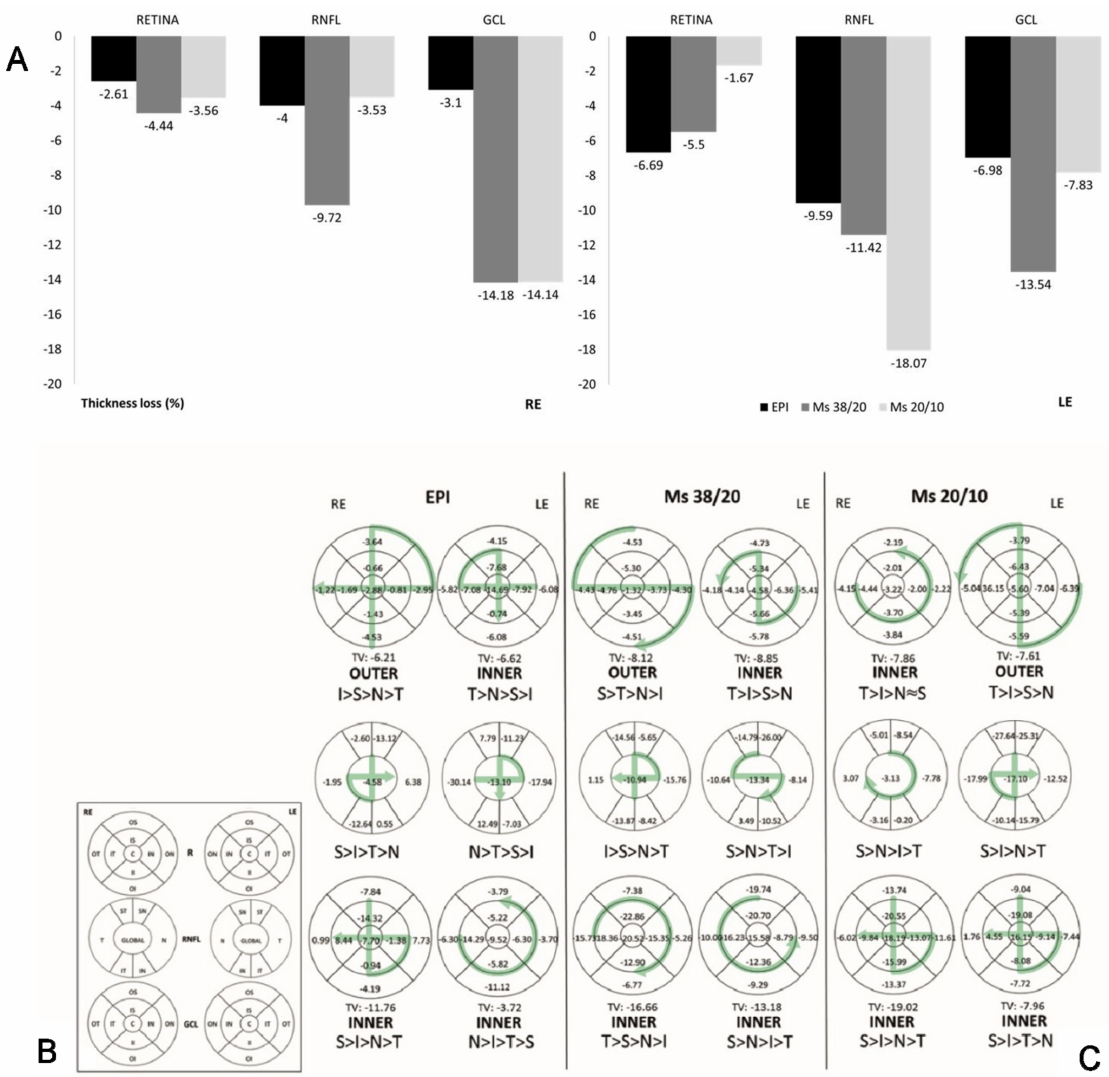
Figure 5. Percentage loss of neuroretinal structure identified by optical coherence tomography (OCT). ( A ) Percentage loss of retina, retinal nerve fiber and ganglion cell layers in the three ocular hypertensive models; ( B ) nomenclature of the neuroretinal sectors using OCT. ( C ) Neuroretinal percentage loss in OCT sectors and loss trend at 8-week follow-up. Abbreviations: R: retina; C: central; II: inner inferior; OI: outer inferior; IS: inner superior; OS: outer superior; IN: inner nasal; ON: outer nasal; IT: inner temporal; OT: outer temporal; RNFL: retina nerve fiber layer; IT: inferior temporal; IN: inferior nasal; ST: superior temporal; SN: superior nasal; N: nasal; T: temporal; GCL: ganglion cell layer complex; RE: right eye; LE: left eye; EPI: episcleral sclerosis model; Ms38/20: 38/20 microsphere model; Ms20/10: 20/10 microsphere model; TV: total volume; I: inferior; S: superior; N: nasal, T: temporal; >: higher loss than; (%): percentage; OCT: optical coherence